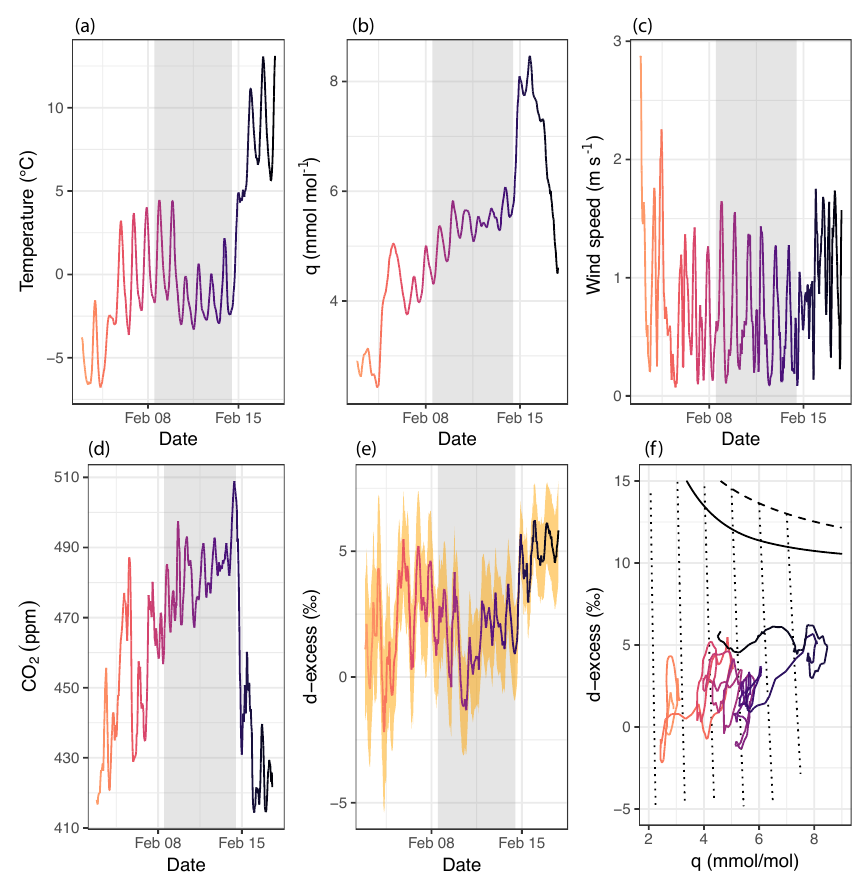
Figure 7. Relationships between meteorology, d-excess, and CO 2 from 3 to 17 February 2016. Time series of temperature ( a , ◦ C), q , ( b , mmolmol − 1 ), wind speed ( c , ms − 1 ), CO 2 ( d , ppm; 1 σ uncertainty in orange shading), and d-excess ( e , ‰), and the relationship between dq vs. q (f) spanning the same time period, with the same color gradient used across time in all four panels. Data are plotted as 6h running